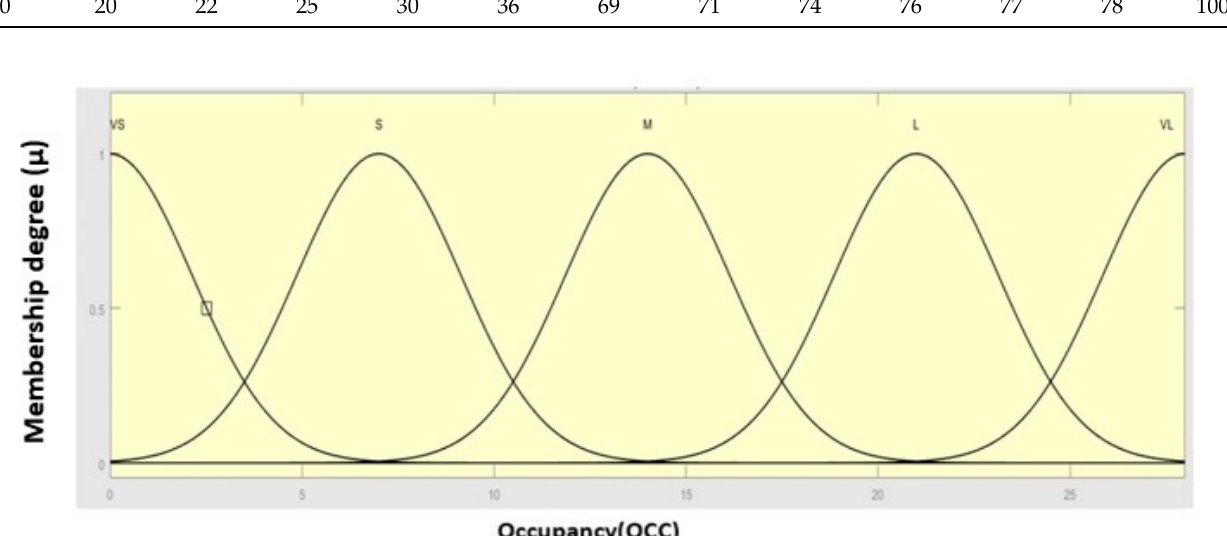
Table 1. The crisp output of the fuzzy controller regarding valve positions (VP). Figure 8. Membership functions of the outdoor temperature. VVS: very very small, VS: very small, S: small, M: medium, L: large, VL:very large, VVL: very very large.